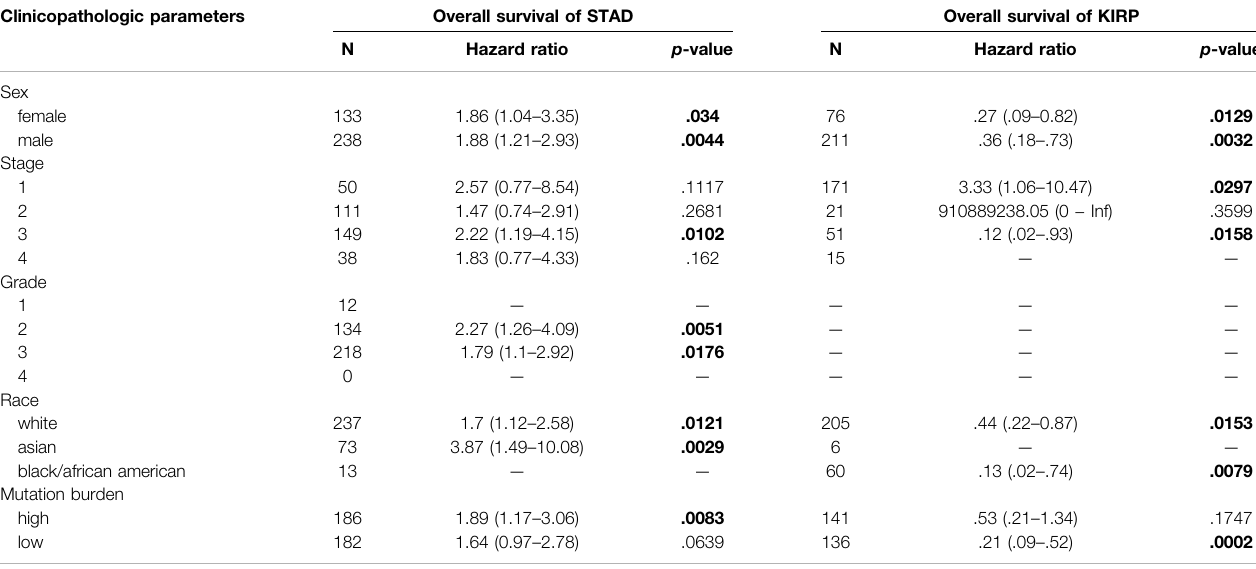
TABLE 1 | Correlation of VSTM2L expression and overall survival in STAD and KIRP with different clinicopathologic parameters by Kaplan-Meier plotter. Clinicopathologic parameters